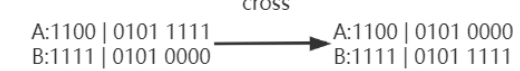
Figure 4. Flow chart of genetic algorithm.